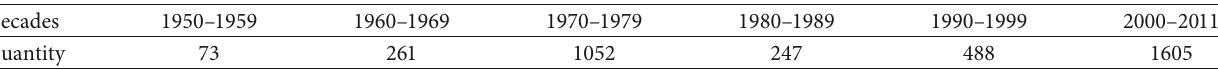
Table 9: Statistics of the quantity of key check dams built in each decade in the